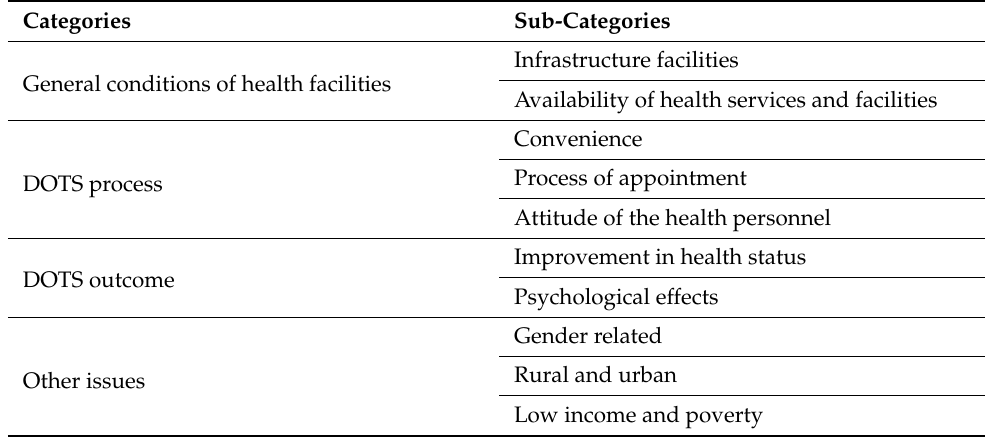
Table 4. Categories and sub-categories identified during qualitative data